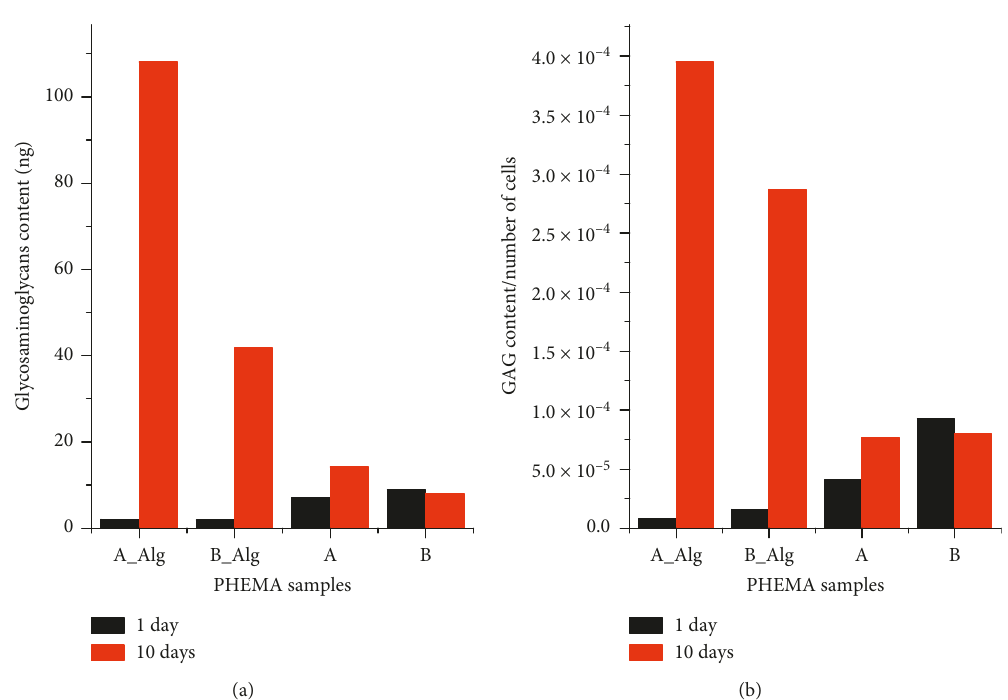
Figure 4: (a) Glycosaminoglycans content (OD) expressed by chondrocytes cultured for 1 or 10 days on the A and B samples with and without alginate (Alg); (b) relationship between the number of the cells and levels of glycosaminoglycans (GAGs) expressed by chondrocytes cultured for 1 or 10 days in A and B samples with and without